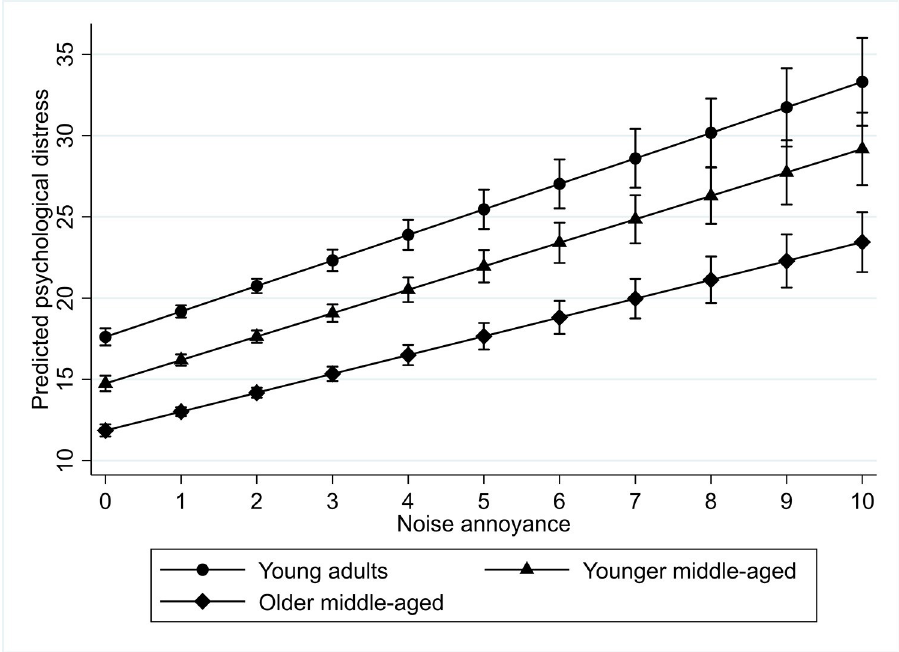
Fig 1. Interaction plot for predicted psychological distress among different age groups by level of noise